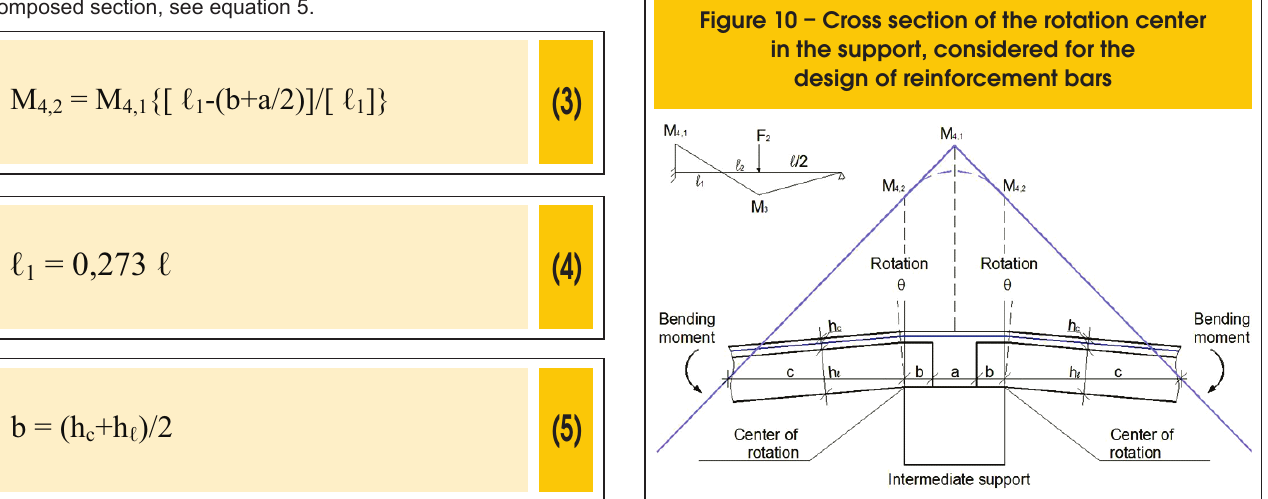
Figure 10 – Cross section of the rotation center in the support, considered for the design of reinforcement